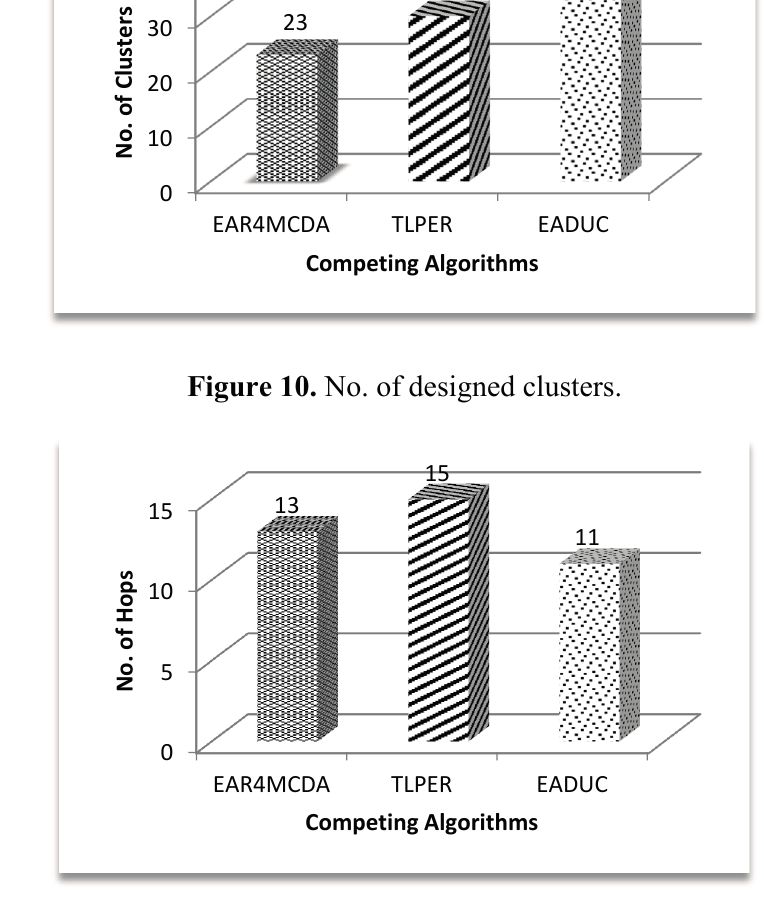
Figure 11. Average no. of hops from end to